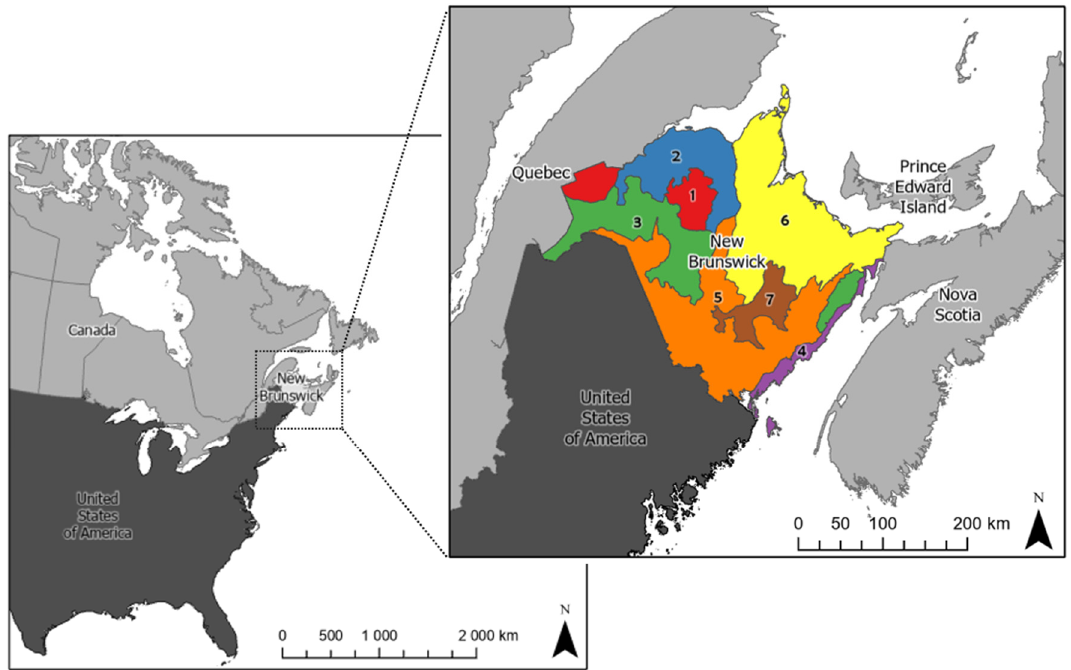
Figure 1. Location of the study area in Eastern Canada with the identification of the seven ecore-